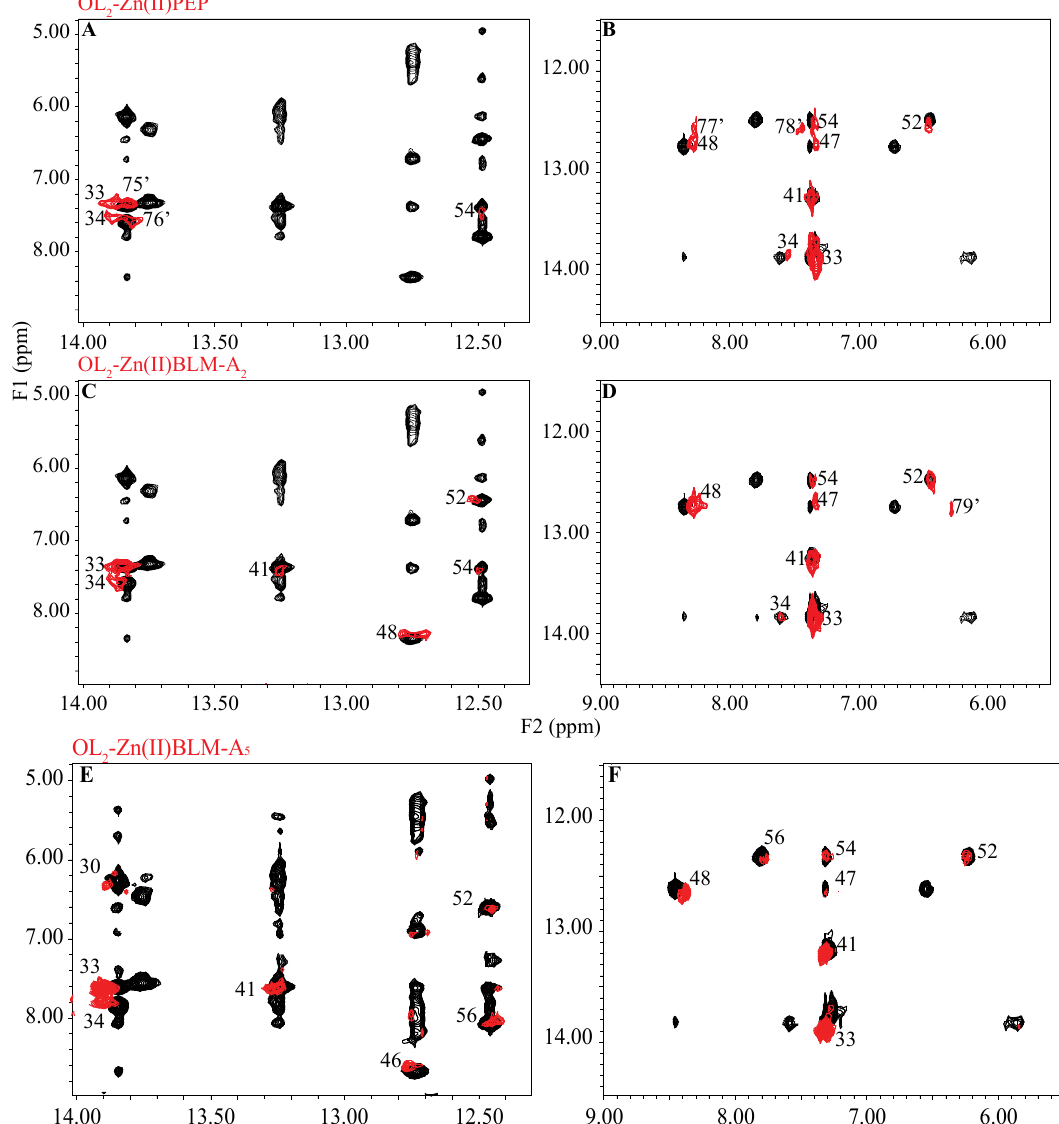
Figure 5. Overlays of the imino region of the NOESY spectra for samples in H 2 O at 5 °C for free OL 2 (black) and OL 2 bound to each Zn(II)BLM (red). Free-OL 2 NOE signals that were conserved upon MBLM binding are labeled with the same numbers used in Figure 3. New NOE signals are labeled primes. The assignments of all these signals is listed in Table S1.